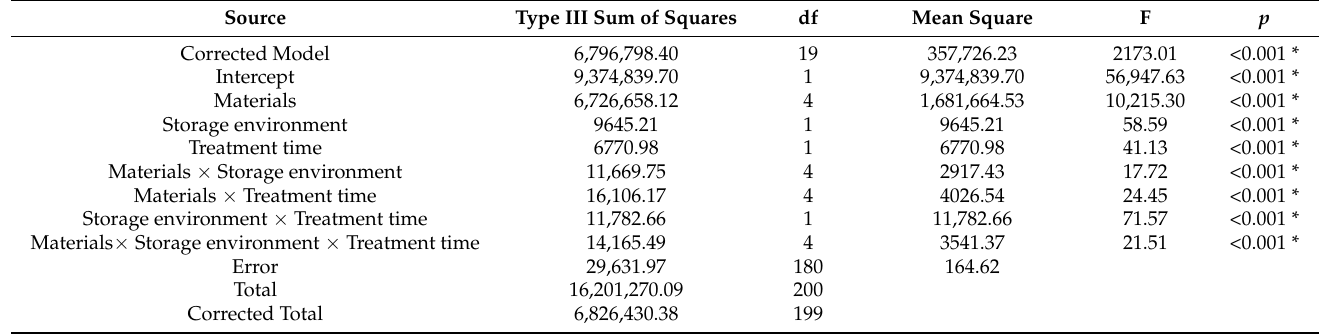
Table 1. Three-way ANOVA for the effect of independent factors and their interaction on microhardness.